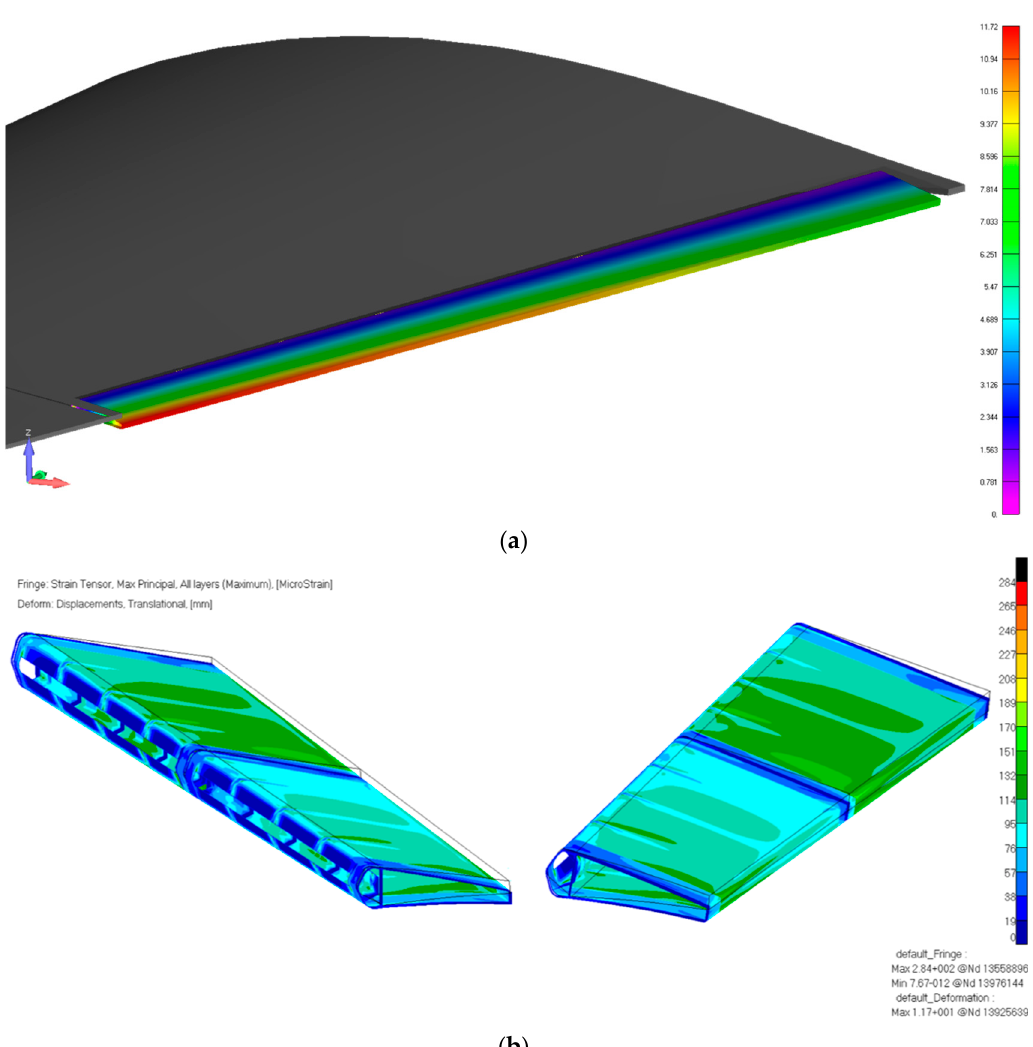
Figure 18. Actuating torques required by the actuation systems for enabling morphing TE modes during high speed climb flight conditions ( 𝑀 (cid:2998) = 0.36 at 4572 m).